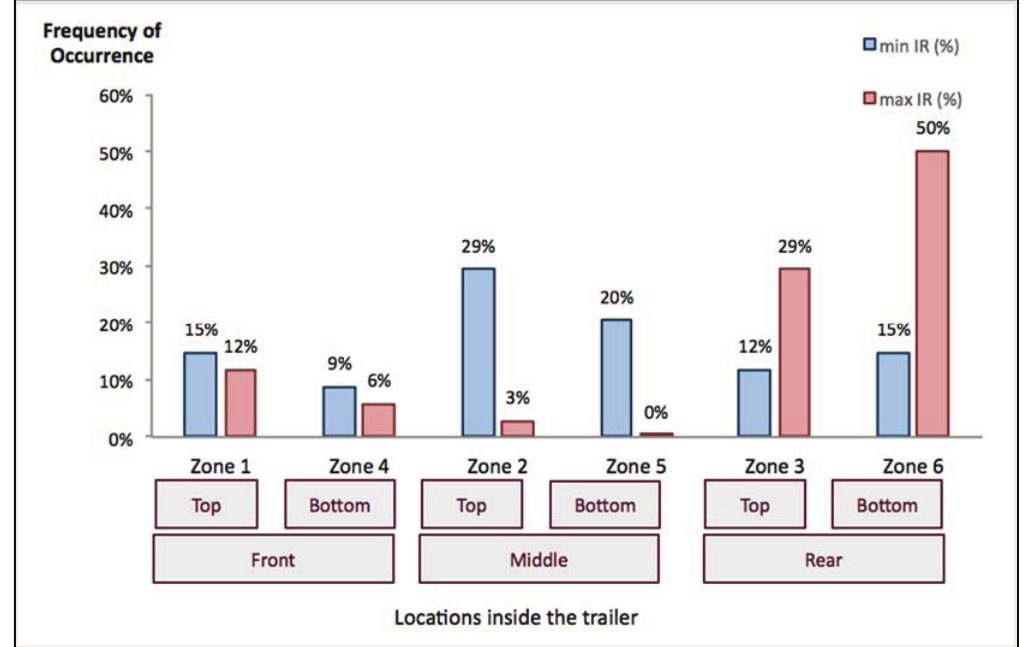
Figure 3. Location and frequency of occurrence of extreme pig surface temperatures within the trailer for 34 monitoring trips over outdoor temperatures ranging from (cid:2)14 to 38 °C (7 to 100